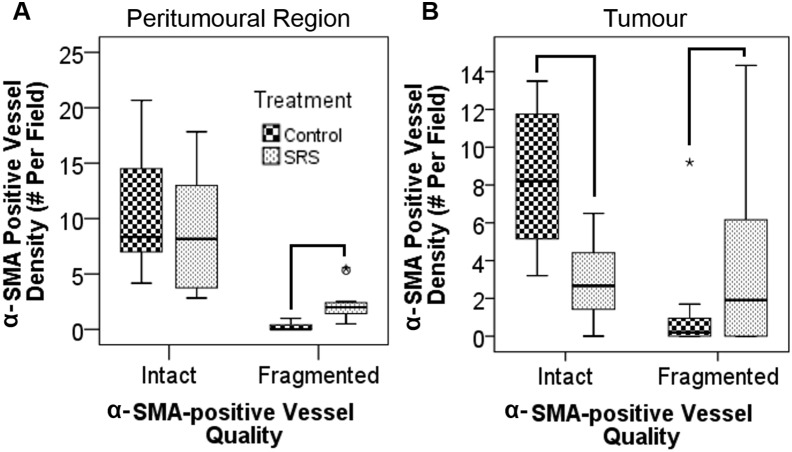
Boxplots of intact and fragmented α-smooth muscle actin (α-SMA) positive vessel densities in (A) peritumoral region and (B) tumor region for the control and SRS groups.Pairs with P<0.01 are connected by black lines.